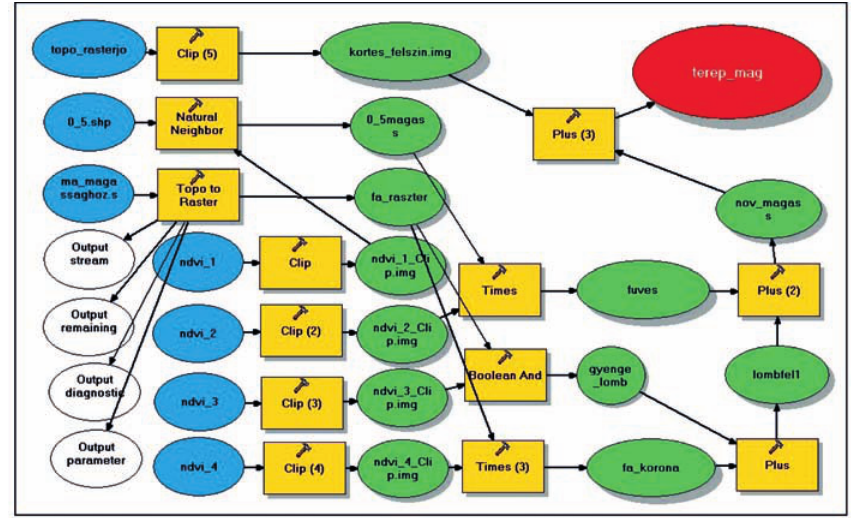
Figure 2. Marco model of the digital surfece model